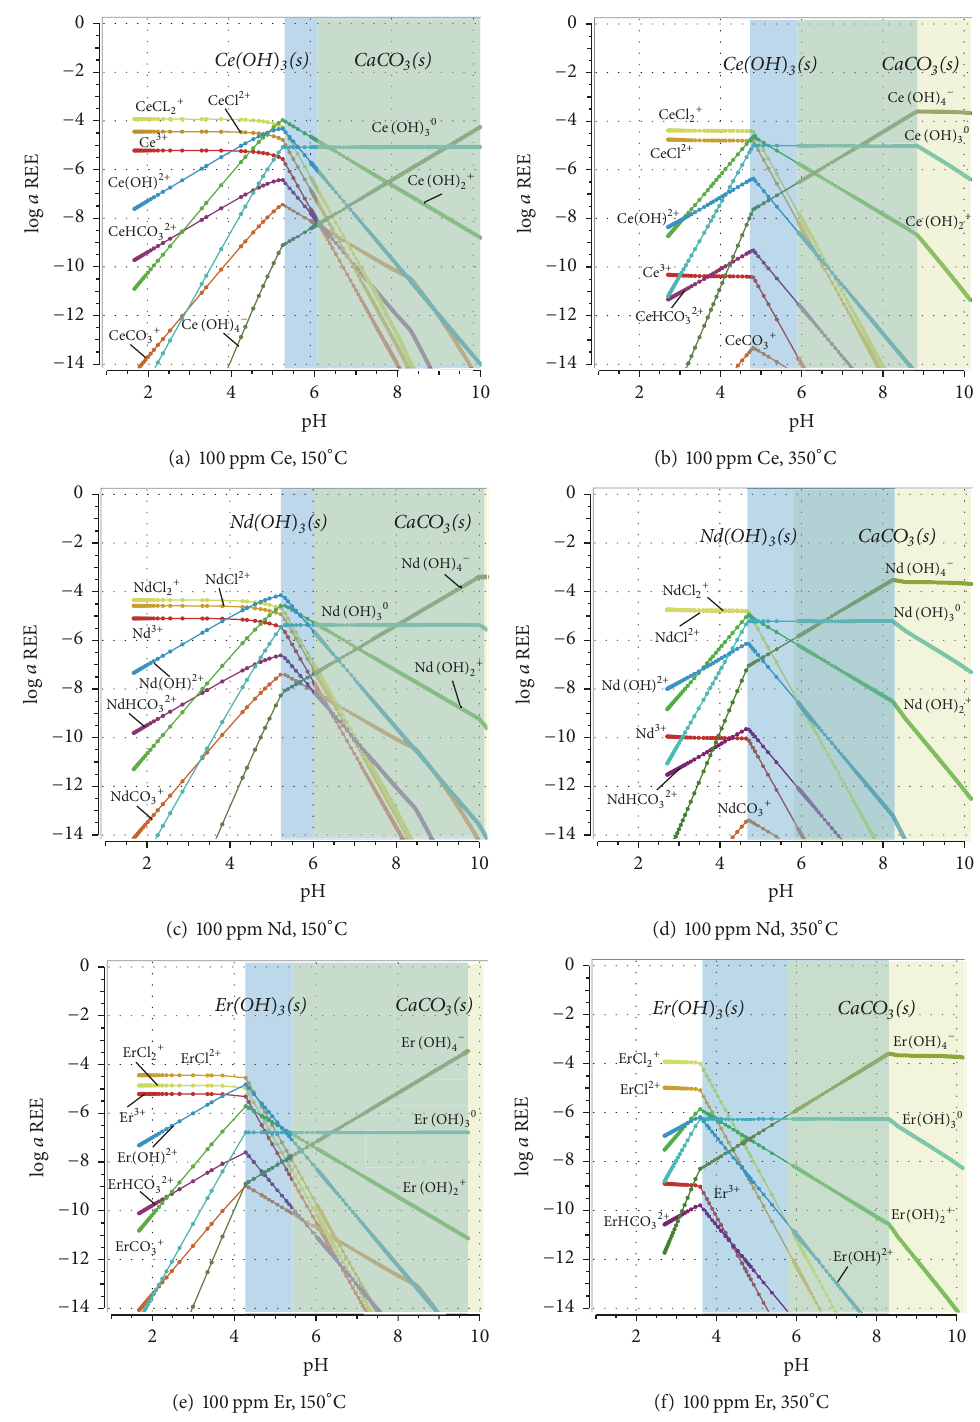
Figure 1: Model Ia (CO 2 -NaCl-poor) showing the REE speciation in a shallow hydrothermal system. Results show the speciation of Ce, Nd, and Er as function of pH at 150 and 350 ∘ C and 𝑝 sat . The starting fluid had a composition of 100 ppm REE, 𝑋 CO 2 of 0.01, and 0.5 wt.% NaCl. The blue field represents the field of REE(OH) 3 (s) stability, while the yellow field corresponds to the stability field of